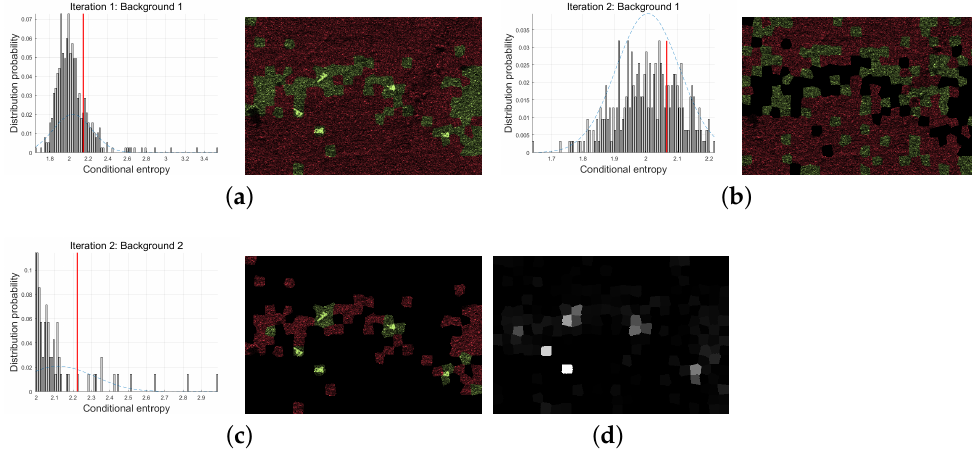
Figure 5. Two iterative simulation SAR image detection results. ( a ) Conditional entropy distribution and outlier detection in the first iteration; ( b ) In the second iteration, the conditional entropy dis- tribution and outlier detection of background 1; ( c ) In the second iteration, the conditional entropy distribution and outlier detection of background 2; ( d ) Iterative accumulation results of Hinge